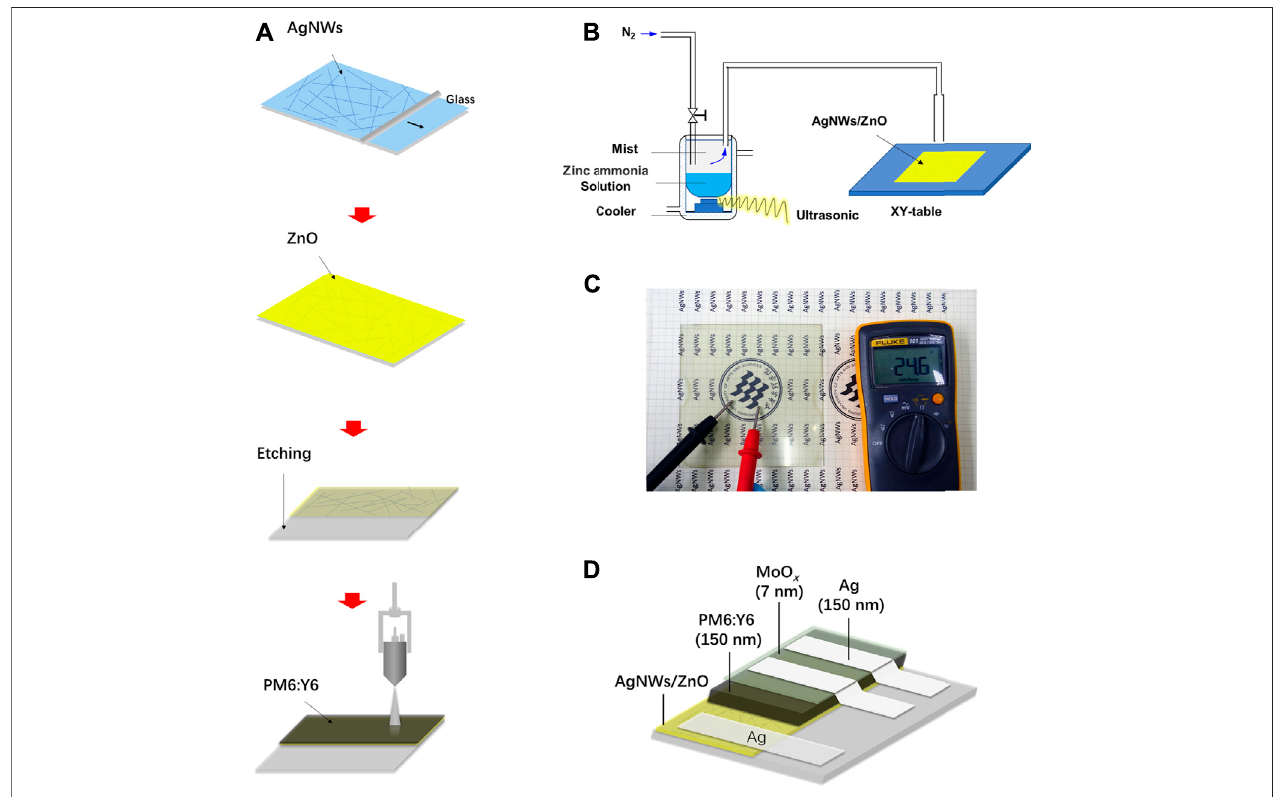
FIGURE 1 | Preparation of AgNWs/ZnO and PM6:Y6 solar cells. (A) Preparation of AgNWs/ZnO and PM6:Y6 blend fi lms, (B) a schematic image of the spray pyrolysisapparatus, (C) aphotograph oftheprepared AgNWs/ZnO fi lmsdeposited onglass, and (D) structure ofthe polymersolarcells situated onaAgNWs/ZnO fi lm.